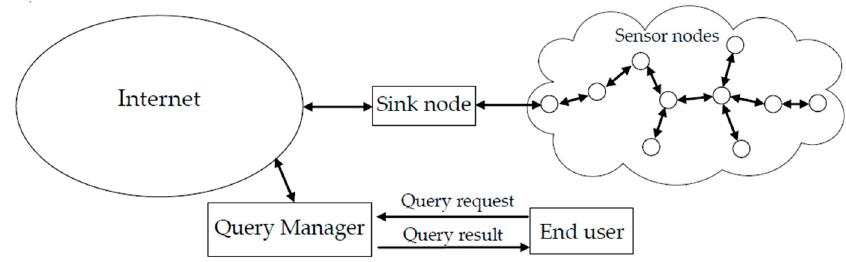
Figure 2. Reference architecture of a WSN.